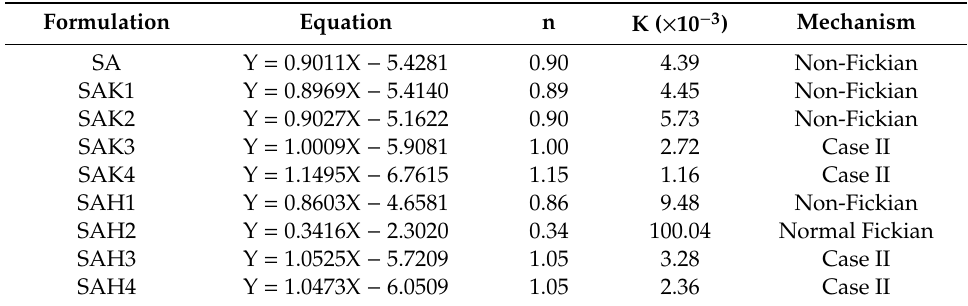
Table 4. Di ff usion constants and mechanism involved in the release process of metalaxyl from di ff erent formulations of